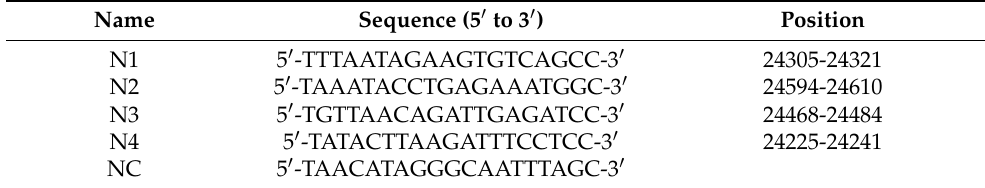
Table 1. The sequences and location of shRNAs targeting the N gene of